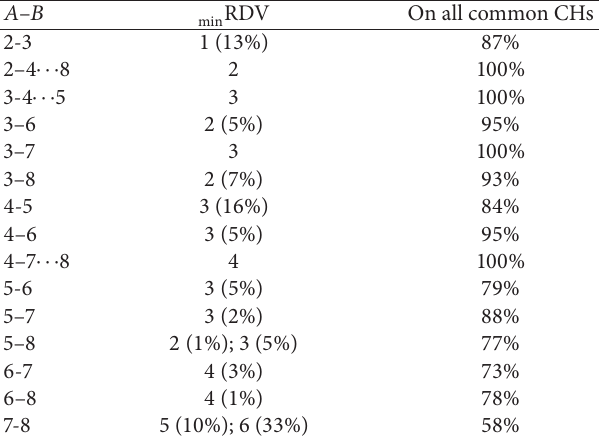
Table 2: MtQS-DSrdv in ACHv: RDV in a larger period of 𝐵; min RDV stands for the minimum number of RDVs (with the